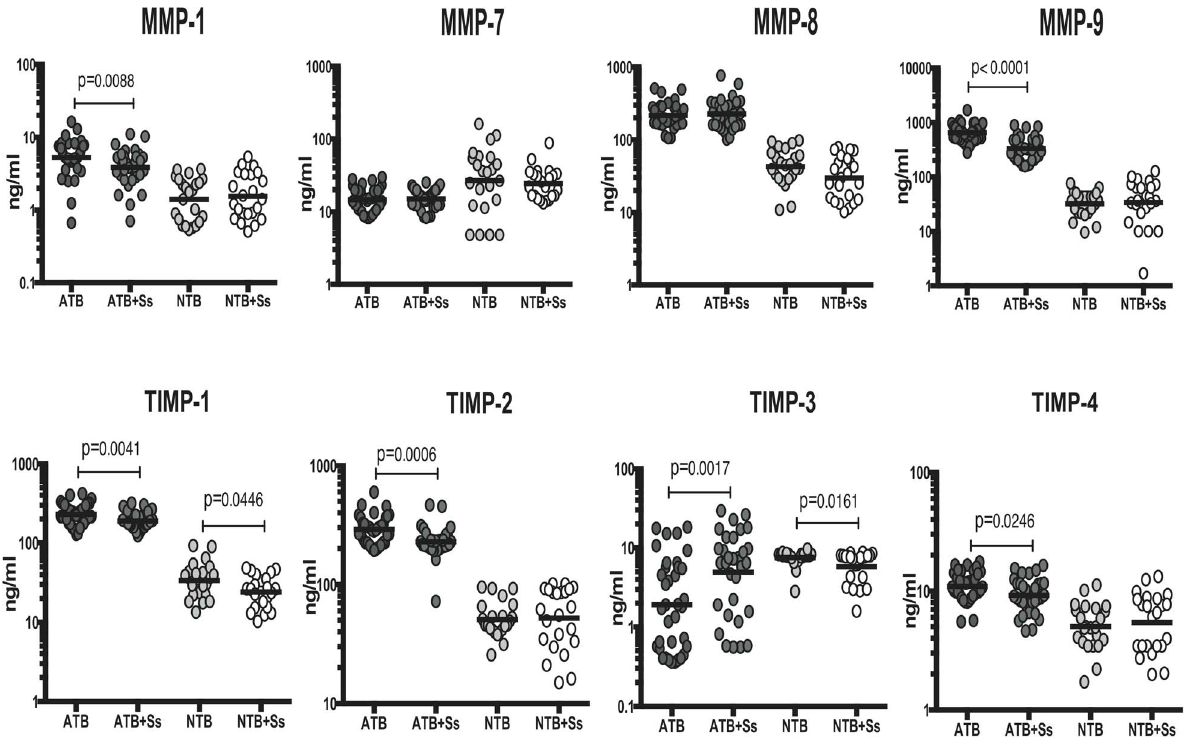
Figure 2. Helminth infections are associated with diminished plasma levels of MMPs and TIMPs in active TB. The plasma levels of MMPs (MMP-1, 7, 8 and 9) and TIMPs (TIMP-1, 2, 3 and 4) were measured by multiplex ELISA in active pulmonary TB individuals with (ATB + Ss, n=36) or without Strongyloides coinfection (ATB, n=33) and in non-TB infected individuals with (NTB + Ss, n=23) or without Strongyloides coinfection (NTB, n=23). The results are shown as scatterplots with each circle representing a single individual and the bar representing the geometric mean. P values were calculated using the Kruskal-Wallis test with Dunn’s multiple comparisons (* p , 0.05, ** p , 0.01, *** p , 0.001, **** p , 0.0001).